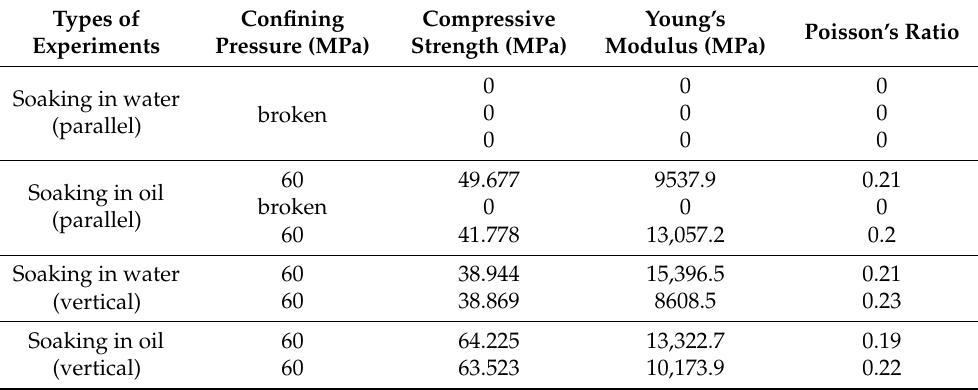
Table 3. 48 h triaxial stress test results of shale soaking.